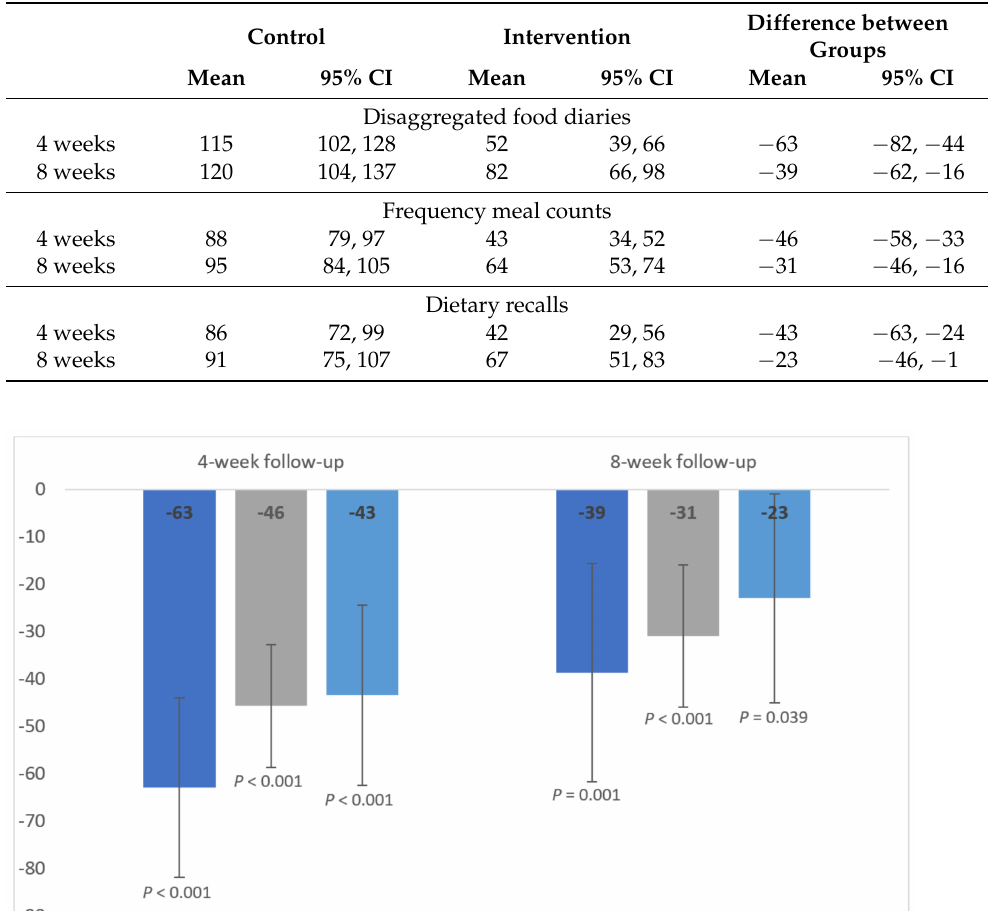
Table 4. Adjusted total meat consumption (g/day) at four- and eight-week follow-ups.